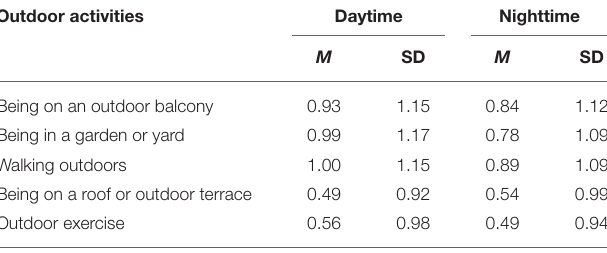
TABLE 4 | Bivariate and multivariate logistic regression predicting depressive symptoms. Score above PHQ8